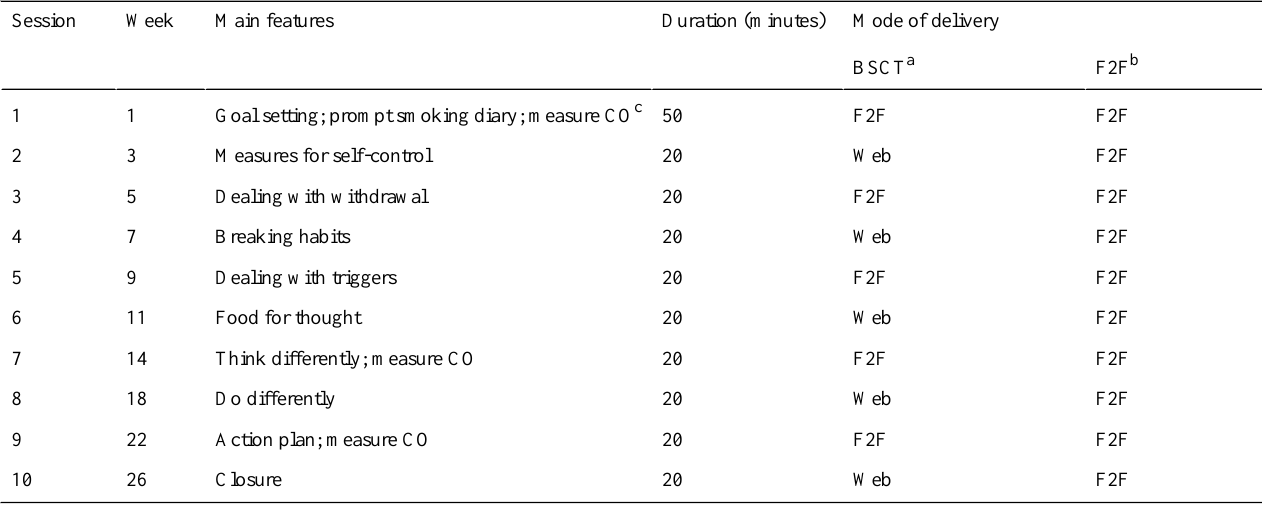
Table 1. Order, timing, main features, duration, and mode of delivery of the treatment sessions in the face-to-face and blended groups according to treatment